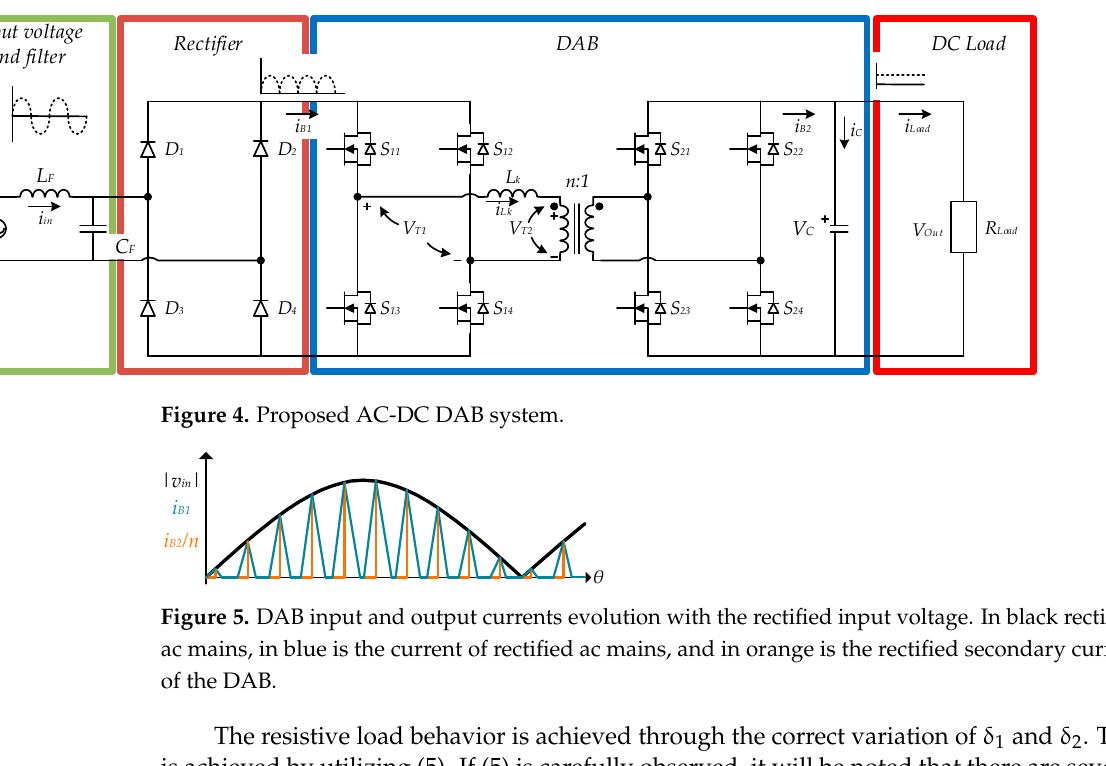
Figure 5. DAB input and output currents evolution with the rectified input voltage. In black recti- fied ac mains, in blue is the current of rectified ac mains, and in orange is the rectified secondary current of the DAB.